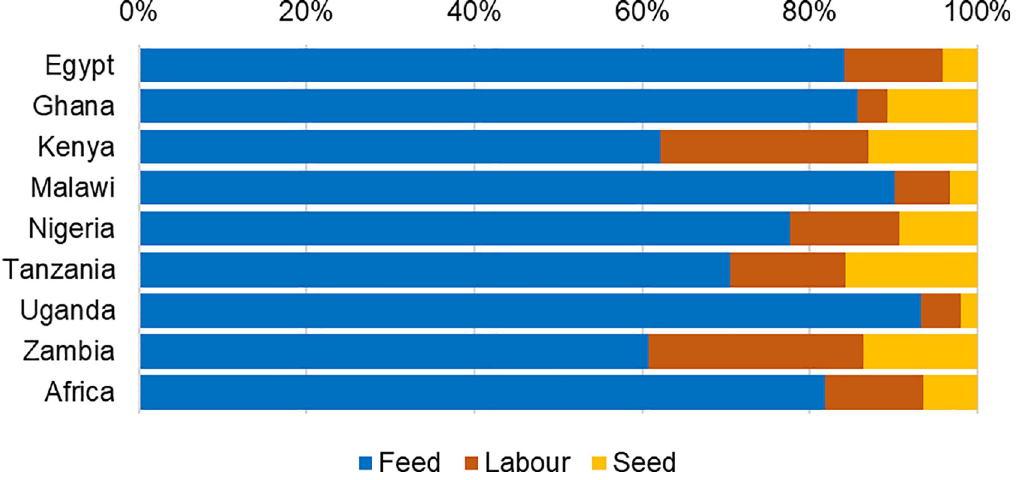
Fig 4. Cost structure of key input production costs of aquaculture in Africa and studied